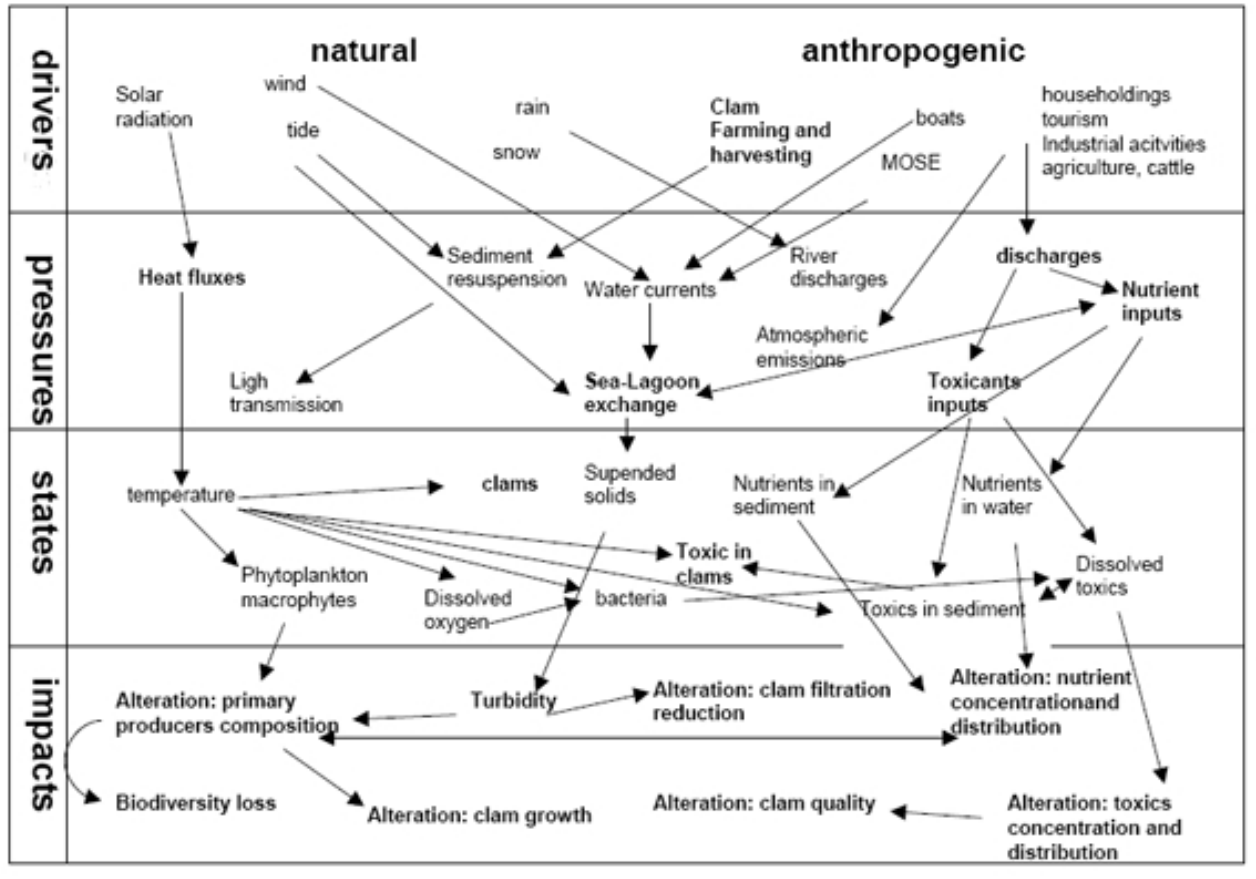
Fig. 2. Drivers, pressures, states, impacts, and pressures (DPSIR) scheme of processes related to clam harvesting in the Venice